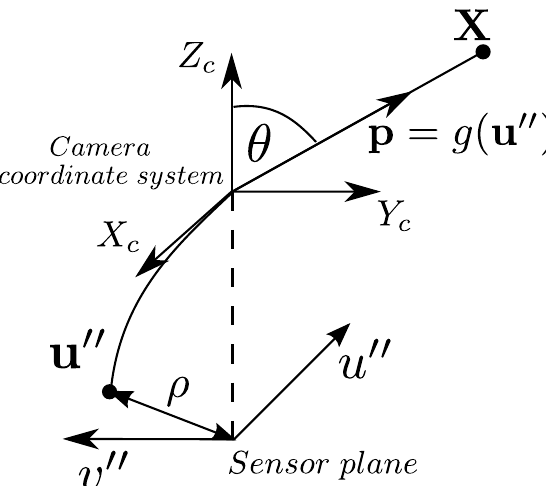
Figure 1: The back-projection of the point u 00 via the non-linear function g is coincident with the scene point X in the camera coordinate system.